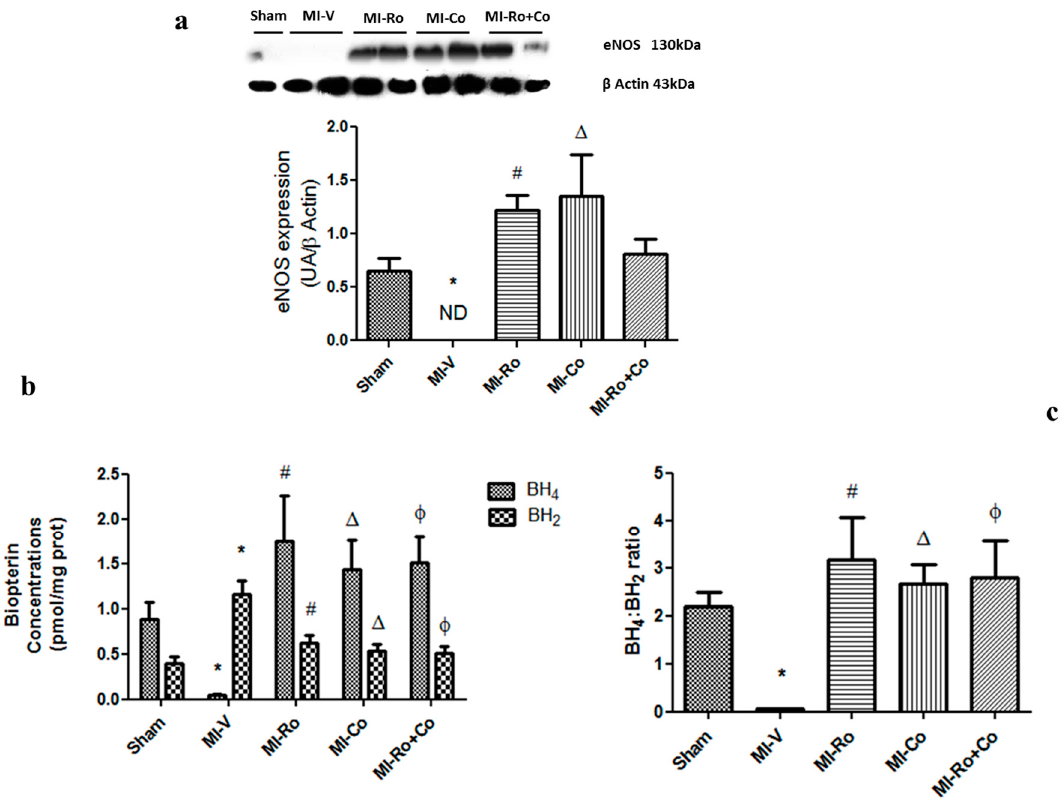
Figure 7. Extracts of Rosmarinus officinalis ( Ro ), Crataegus oxyacantha ( Co ), and their combination ( Ro+Co ) increases endothelial nitric oxide synthase (eNOS) expression and BH 4 :BH 2 ratio. ( a ) Representative immunoblot and eNOS expression; ( b ) biopterin concentrations; and ( c ) BH 4 :BH 2 ratio in ischemic areas from sham, myocardial infarction (MI)-vehicle (MI-V)-treated, MI- Ro , MI- Co , and MI- Ro+Co . The values correspond to the mean ± SEM of six rats/group. p < 0.05 ANOVA one way post Tukey, * Sham vs. MI-V, # MI-V vs. MI- Ro , Δ MI-V vs. MI- Co , Φ MI-V vs. MI- Ro+Co .